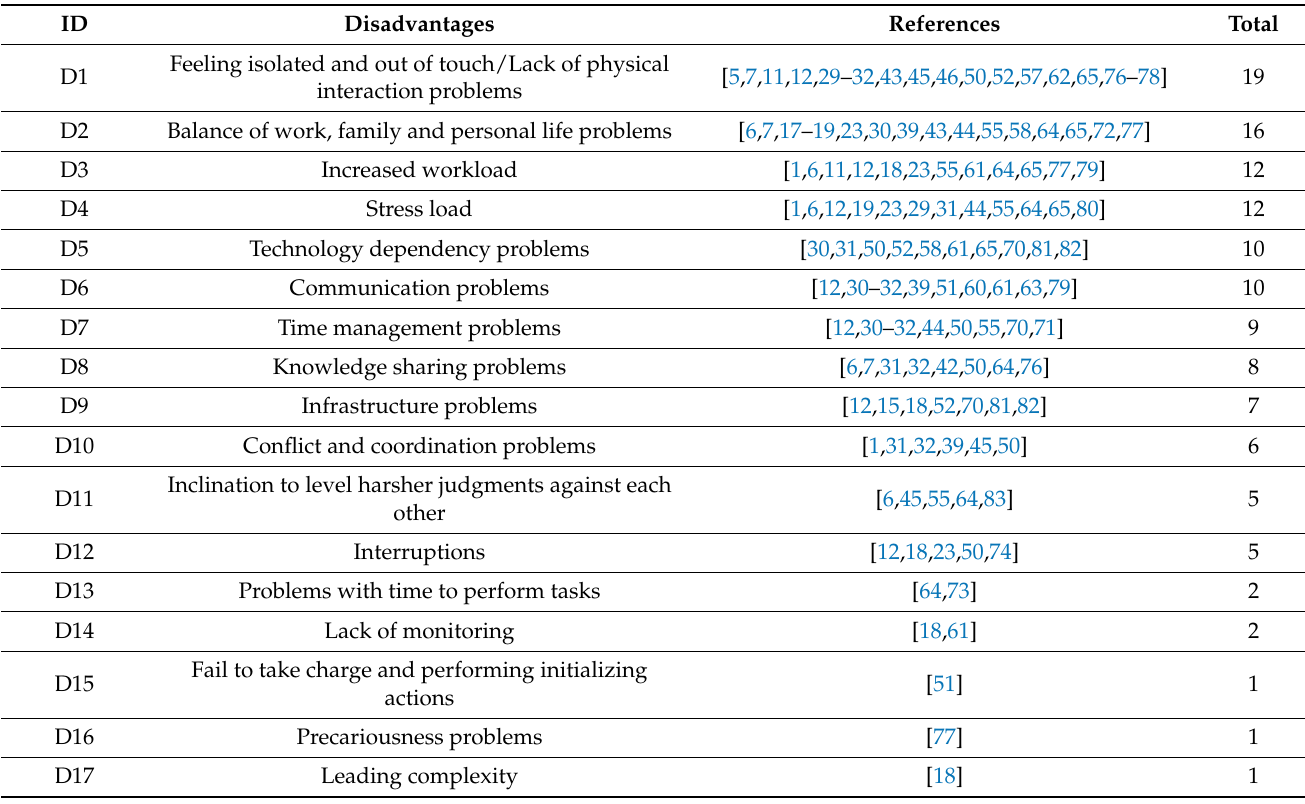
Table 6. RW disadvantages elicited from the performed SLR.